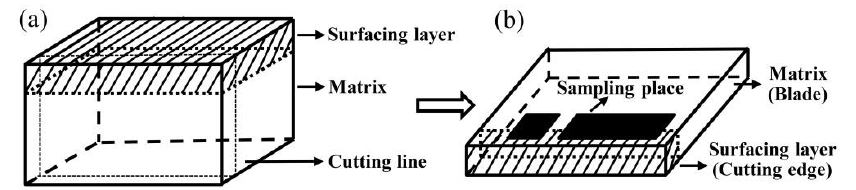
Figure 1. Cutting and sample selection. ( a ) position of cutting line in composite surfacing materials; ( b ) sampling zone in composite surfacing materials.